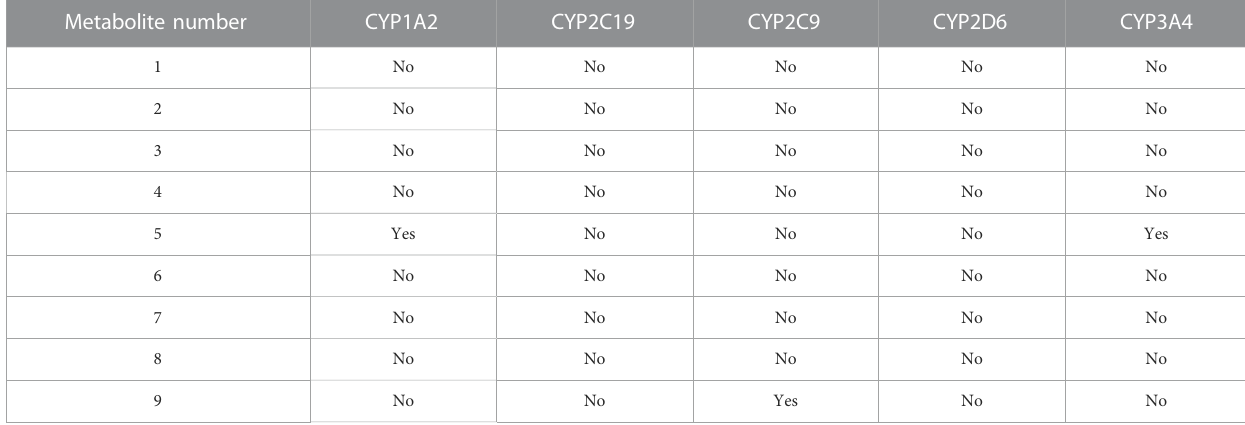
TABLE 4 Predicted effects of the metabolite-derived L. shawii extract on CYP enzyme inhibition using the SwissADME webserver. Metabolite